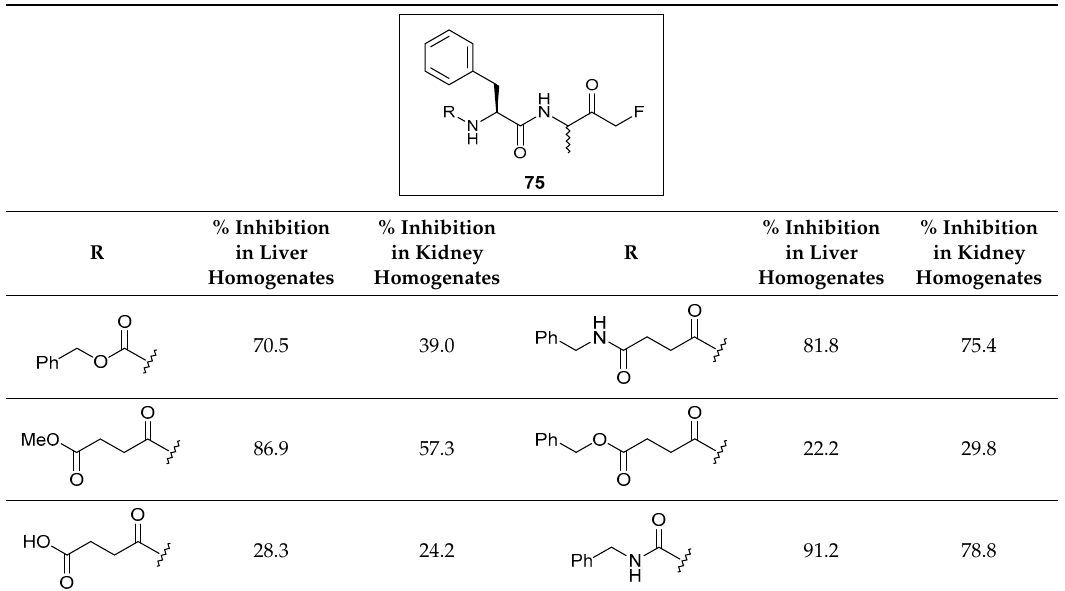
Table 1. % Inhibition of cathepsin B in liver and kidney tissue homogenates treated with 25 mg/kg of a selection of peptidyl FMKs [1].